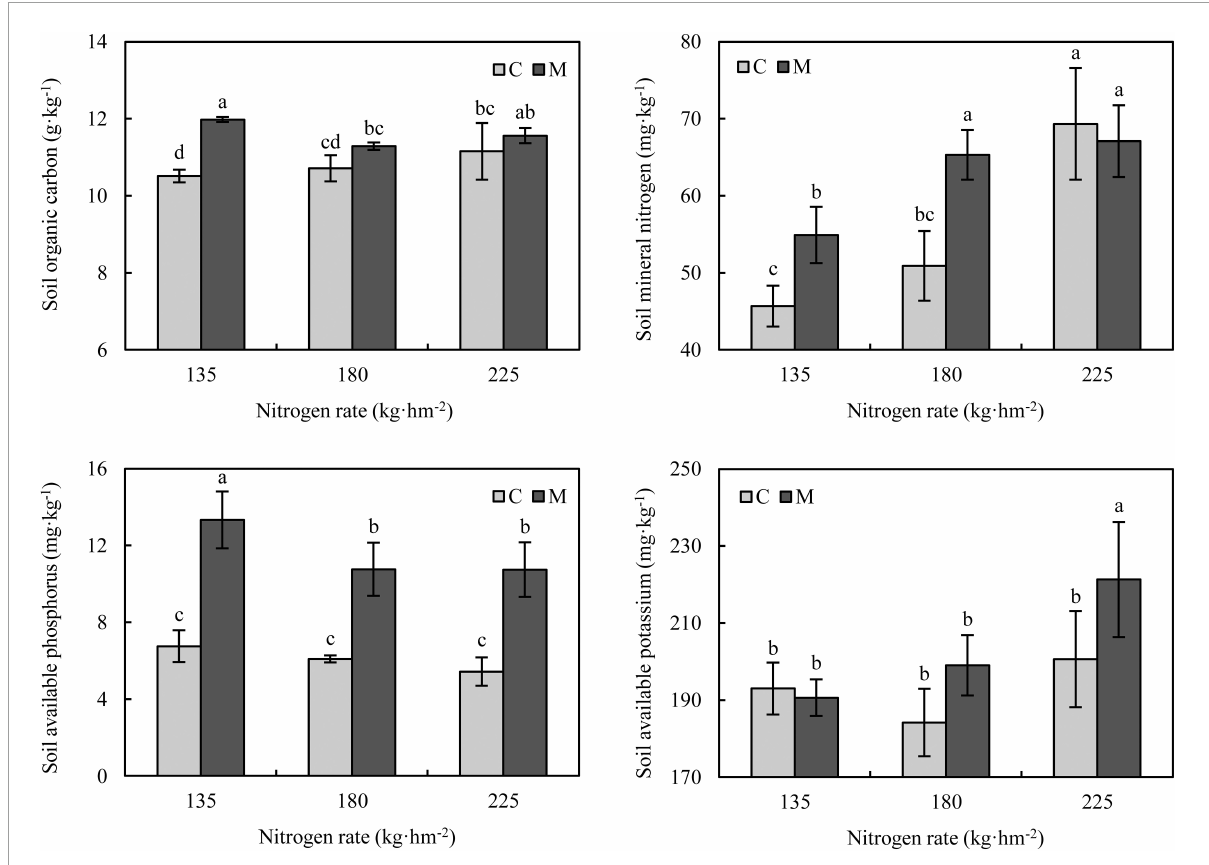
FIGURE1 Soil organic carbon and available nutrients under different nitrogen and manure treatments. M and C indicate treatments with and without chicken manure application, respectively. Error bars represent standard deviations ( n = 3). Different letters above bars indicate significant difference at 0.05 level.